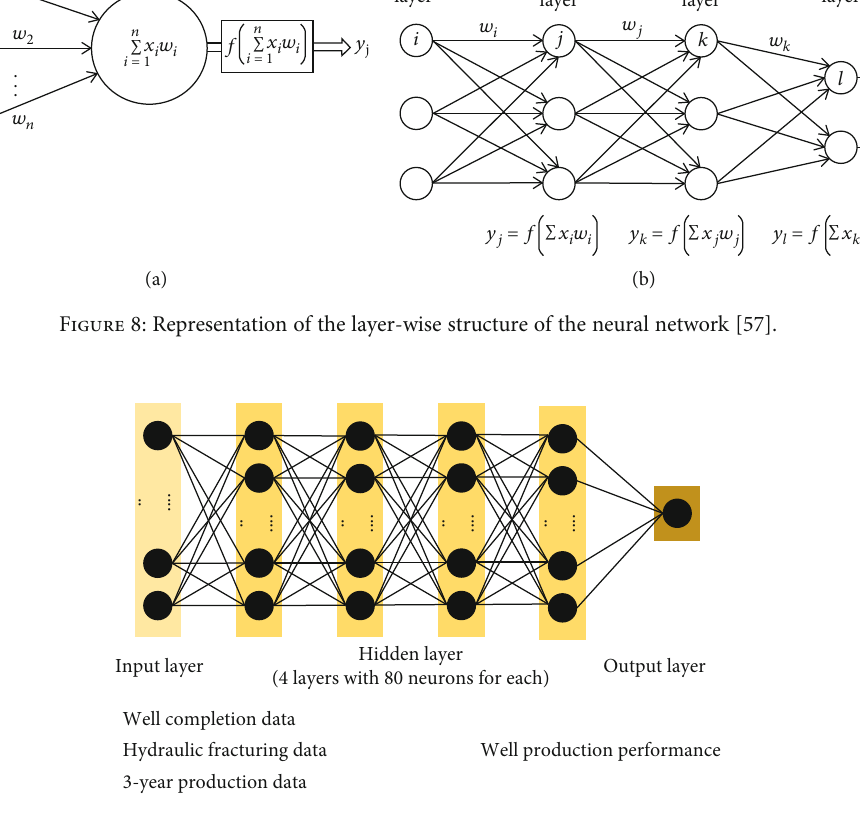
Figure 9: Representation of the layer-wise structure of the neural network used in this work.